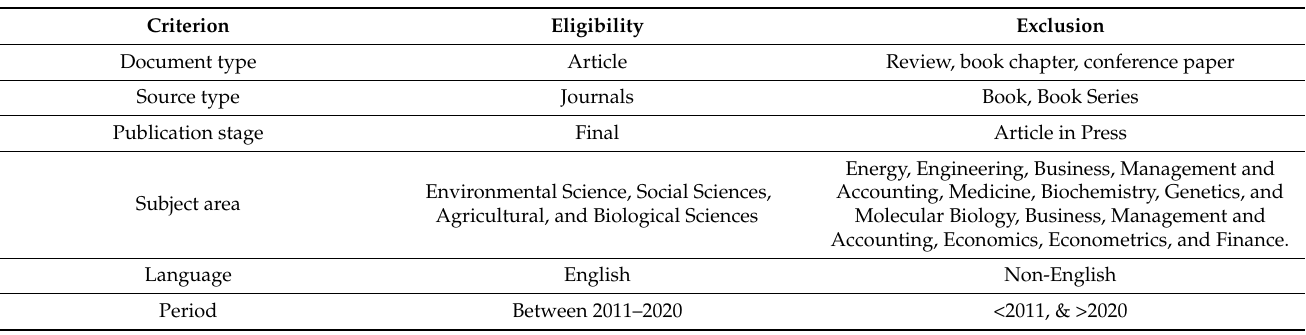
Table 1. Criteria for inclusion and removal.